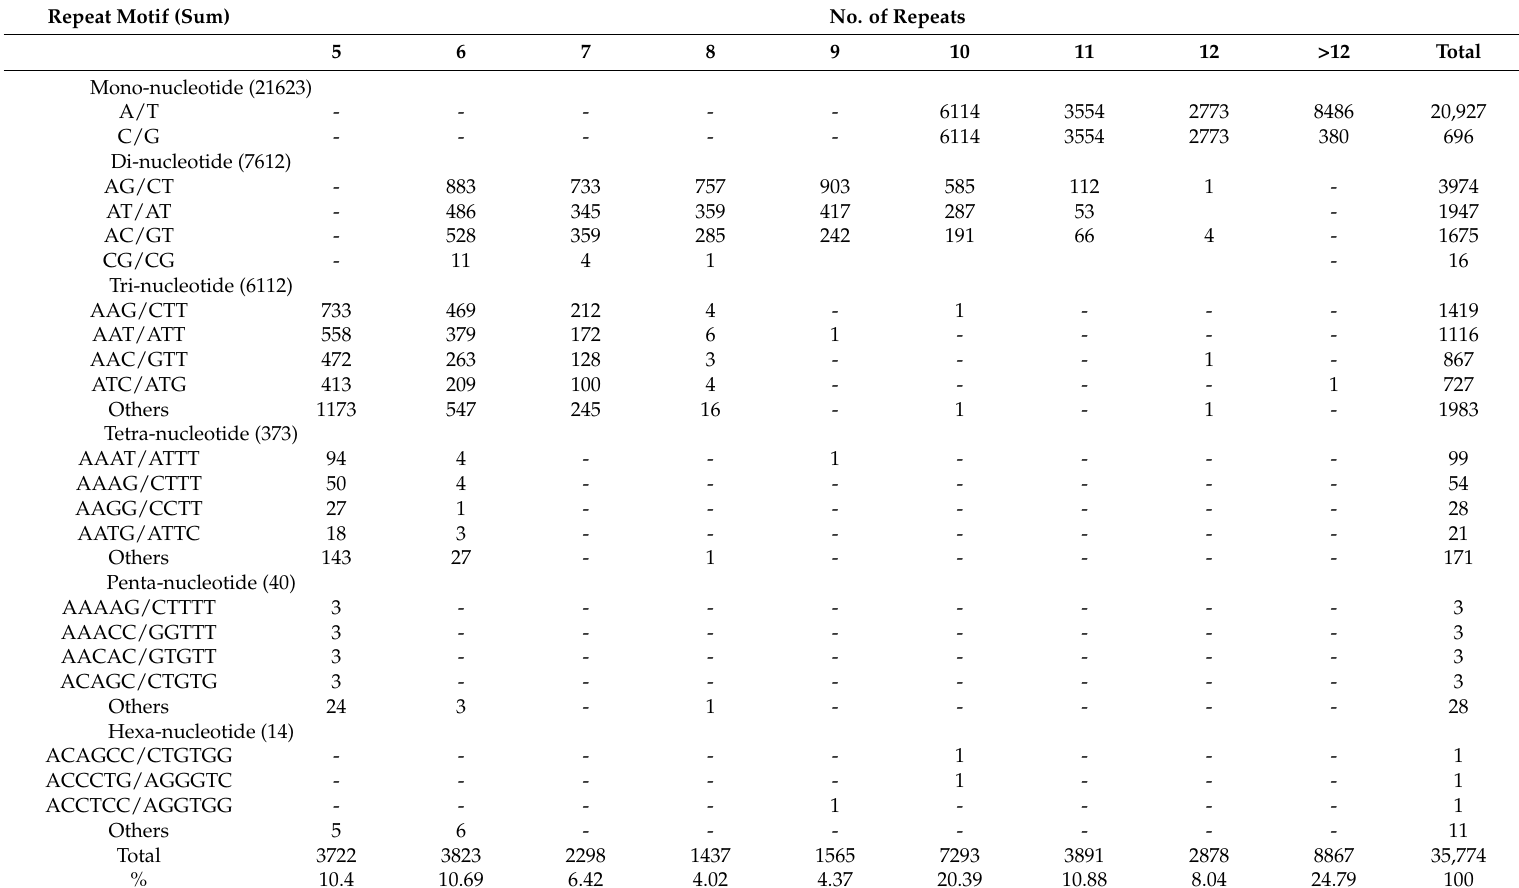
Table 3. Details of the different SSRs (simple sequence repeats) distribute in D.